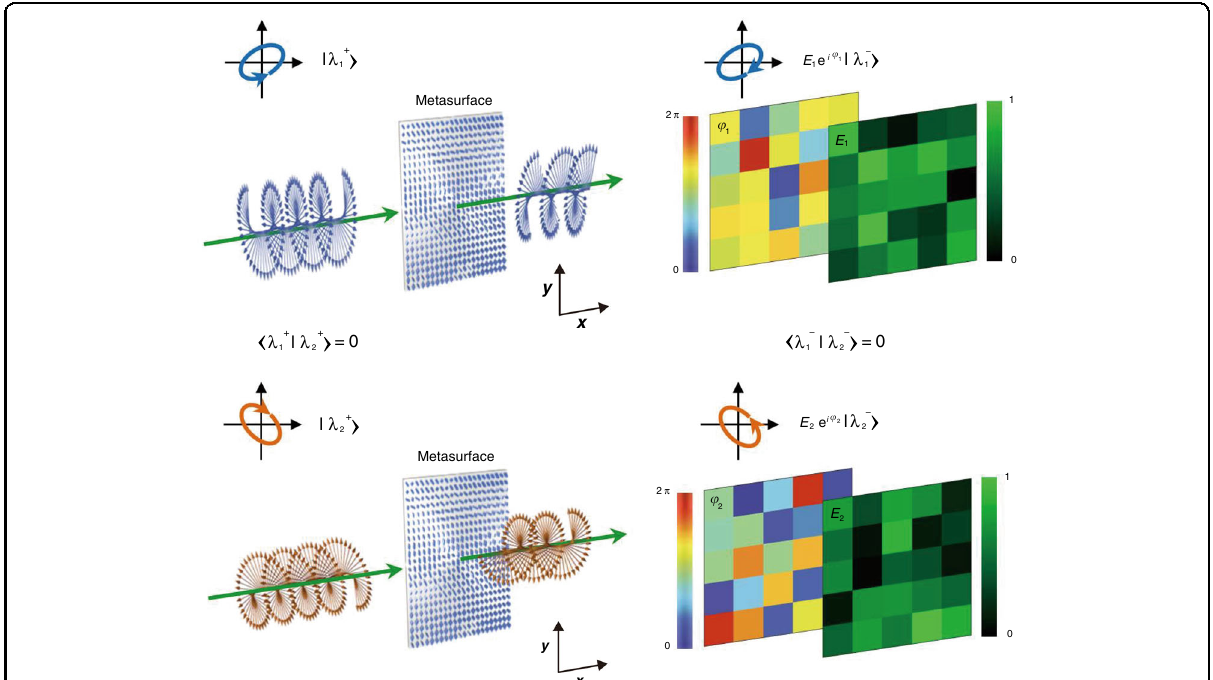
Fig. 1 Conceptual illustration of a multifunctional metasurface. The proposed single-layer multifunctional metasurface can achieve arbitrary and independent amplitude and phase control for a pair of orthogonal polarization states. Upon transmission, the handedness of each output polarization (| λ 1 − 〉 , | λ 2 − 〉 ) is fl ipped, with respect to the incident polarization (| λ 1 + 〉 , | λ 2 + 〉 ). The output wavefront can possess any combination of arbitrary complex-amplitude distributions of E 1 e i φ 1 and E 2 e i φ 2 . The phase and amplitude pro fi les ( φ 1 , φ 2 , E 1 , and E 2 , respectively) for the two orthogonal polarization states are independent of each